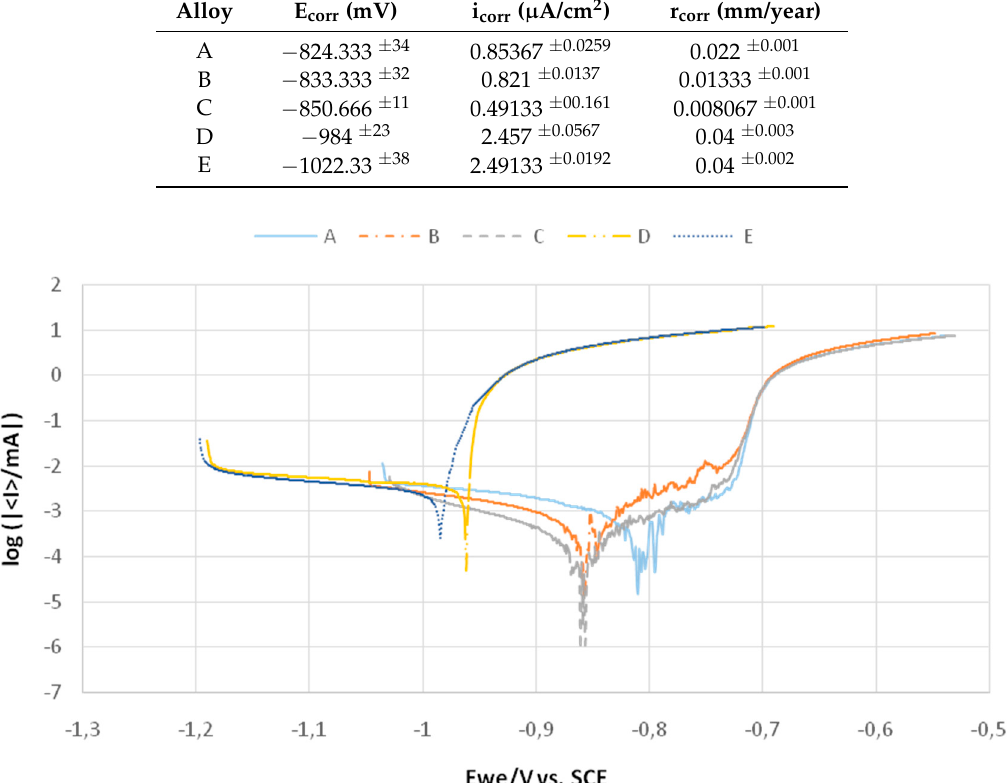
Figure 9. Potentiodynamic polarization curves of the experimental materials in 0.1 M NaCl solution.